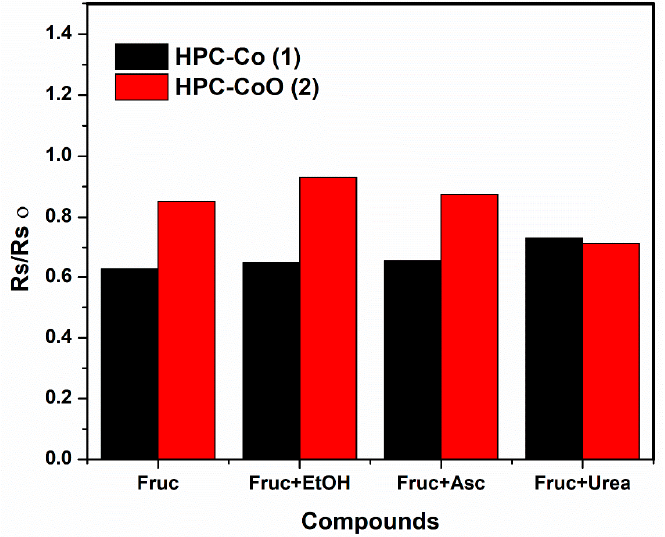
Figure 13. Recorded Rs/Rso of 10 mM fructose in the absence and presence of 10 mM of each of urea, ascorbic acid, and ethanol by HPC-Co and